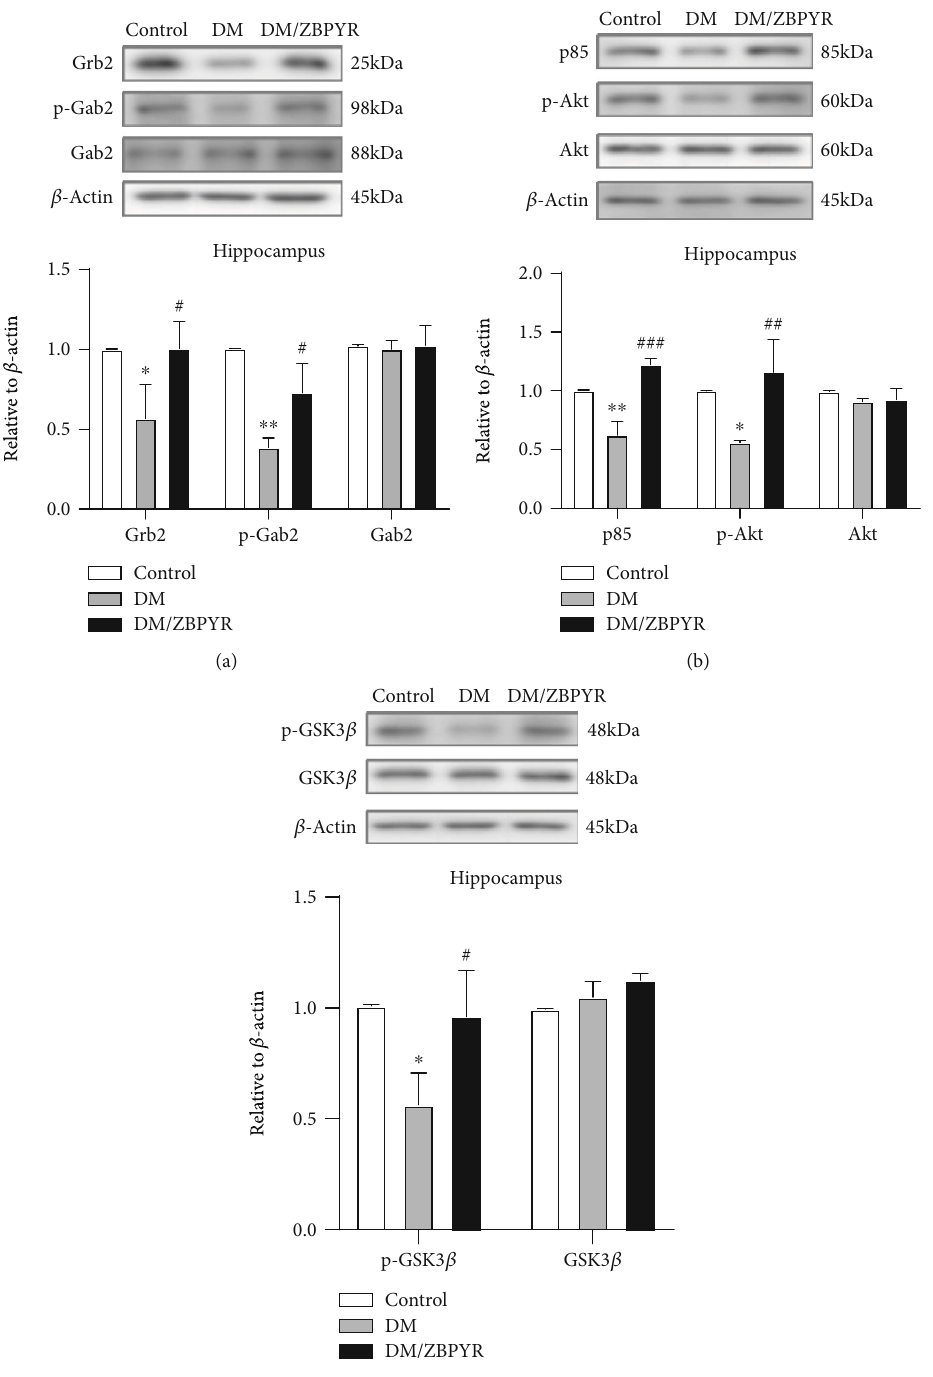
Figure 3: The e ff ect of ZBPYR on the expression of Grb2, Gab2, Akt, p-Akt, and GSK3 β in mouse hippocampus. (a) Compared with the control group, the expression of Grb2 in the hippocampus of the DM group was reduced. However, Grb2 levels increased after ZBPYR administration. The total level of Gab2 in the hippocampus did not change signi fi cantly between the three groups. The expression of p- Gab2 (Tyr452) in the hippocampus of DM/ZBPYR mice was moderately increased. (b) The levels of p85 and p-Akt (Ser473) were reduced in DM, while ZBPYR enhanced p85 and Akt hyperphosphorylation. The total Akt level was not di ff erent in the hippocampus between the three groups. (c) DM group hippocampus Ser9-phosphorylated GSK3 β decreased, while p-GSK3 β (Ser9) levels in the DM/ZBPYR group hippocampus increased. Values are means ± S : D : from 3 mice in each group. ∗ p < 0 : 05 and ∗∗ p < 0 : 01 compared to control; # p < 0 : 05 , ## p < 0 : 01 , and ### p < 0 : 01 compared to